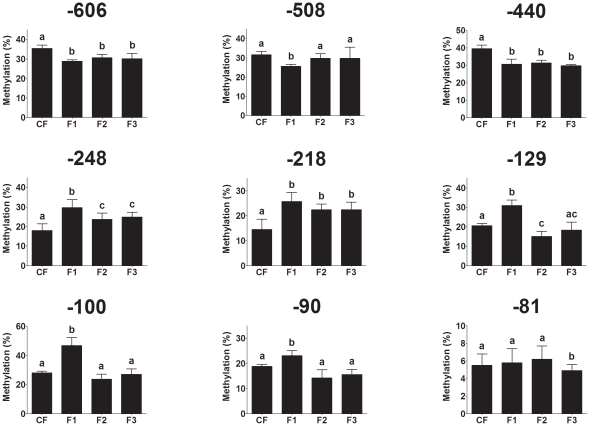
Methylation of individual CpGs in the PEPCK promoter in the liver of the adult offspring.CpG locations (bp) are relative to the transcription start site. Values are mean ± SD of 5–7 samples. Values with different letters are significantly different (P<0.05).